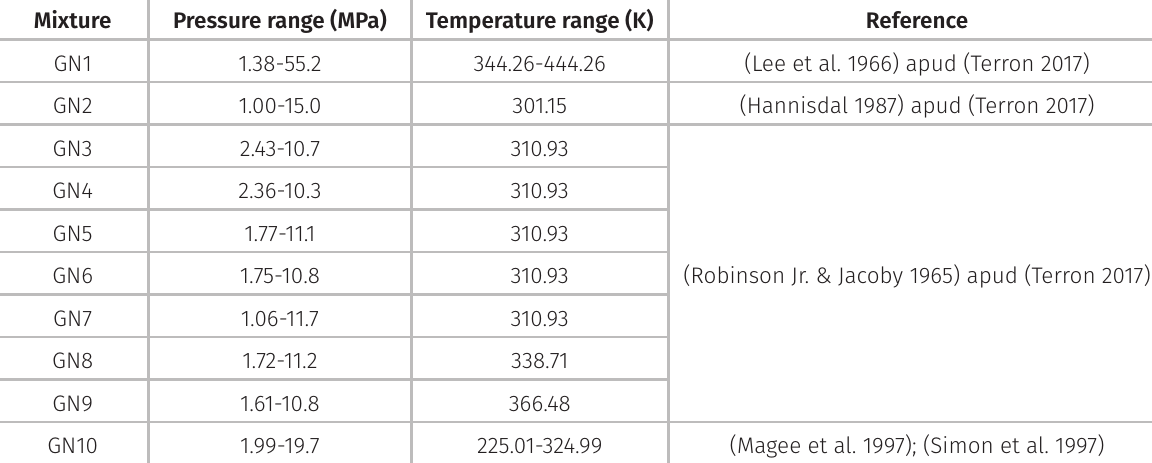
Table IV. Reference, pressure and temperature range of the mixtures used for molar volume